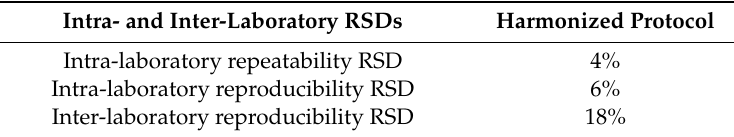
Table 8. Synthesis of the French inter-laboratory